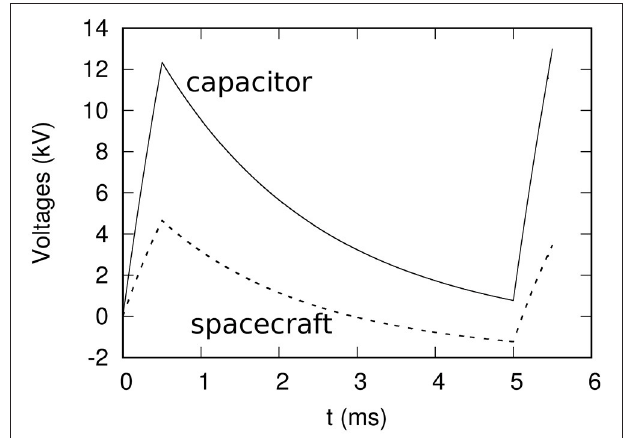
FIGURE 2 | Spacecraft and capacitor voltages over a 5.5 ms time period.